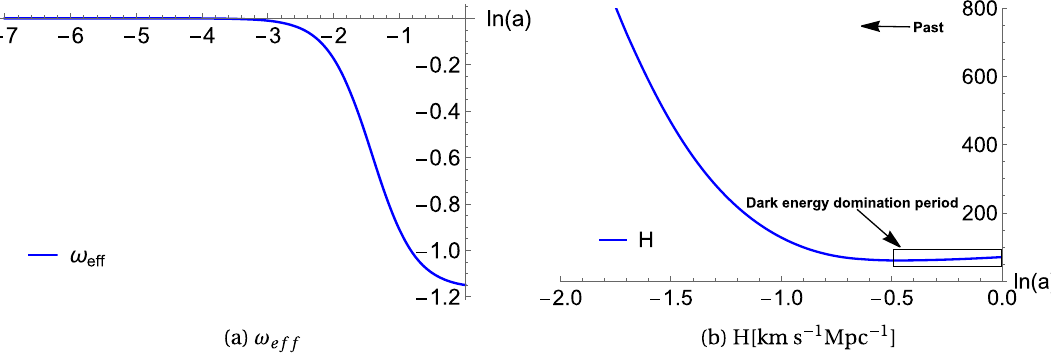
Fig. 8 The evolution of the effective equation of state parameter ( ω ef f ) and the Hubble parameter (H) as a function of N = ln(a) for an interacting DE–DM